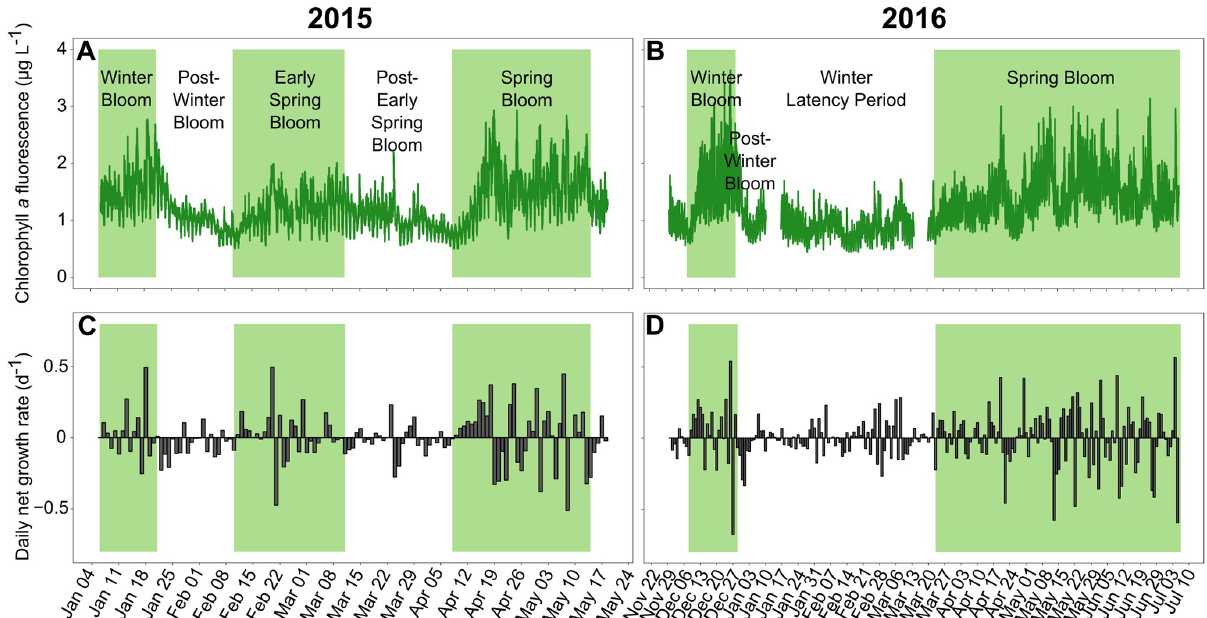
Fig 2. Chlorophyll a fluorescence and daily net growth rates. In situ Chl a fluorescence in 2015 (A) and 2016 (B) and daily net growth rates in 2015 (C) and 2016 (D), indicating daily biomass gains (positive values) and losses (negative values). The bloom periods have a green background, and the post-bloom periods and winter latency period have a white